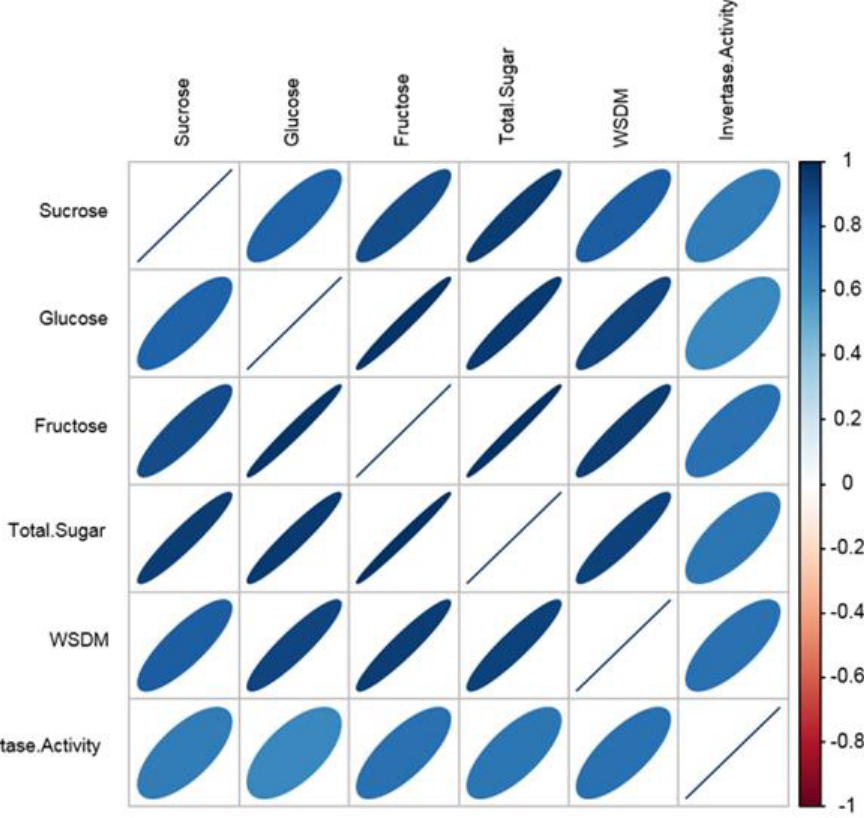
Figure 2. Correlation plot belonging to six different biochemical traits of two strawberry cultivars at four growing